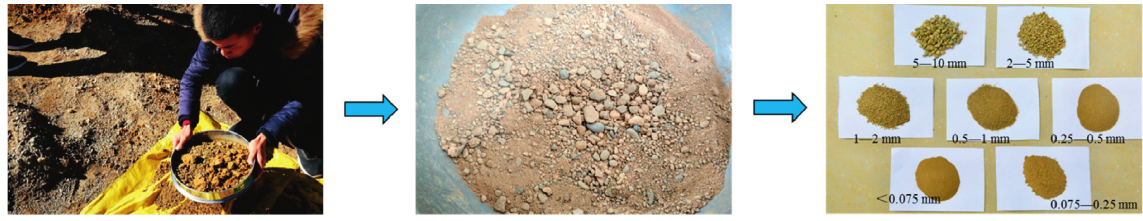
Figure 1: Sampling map.